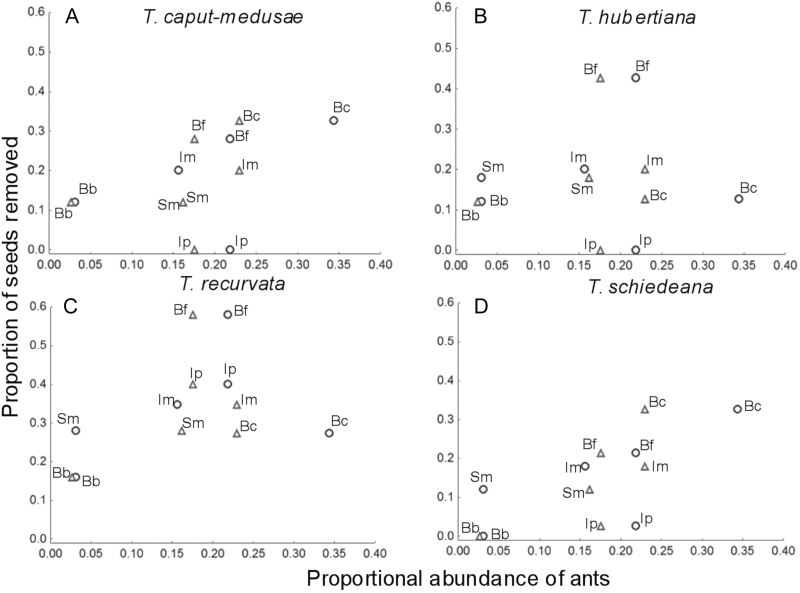
Relationship between the proportion of removed seeds of four epiphyte species and the abundance of two ant species (Camponotus rectangularis willowsi, circles; Crematogaster curvispinosa, triangles) on six host tree species of the tropical dry forest of San Andrés de la Cal, Tepoztlán, in Morelos, Mexico. Bb = Bursera bibinnata; Bc = B. copallifera; Bf = B. fagaroides; Im = Ipomoea murucoides; Ip = I. pauciflora; Sm = Sapium macrocarpum.